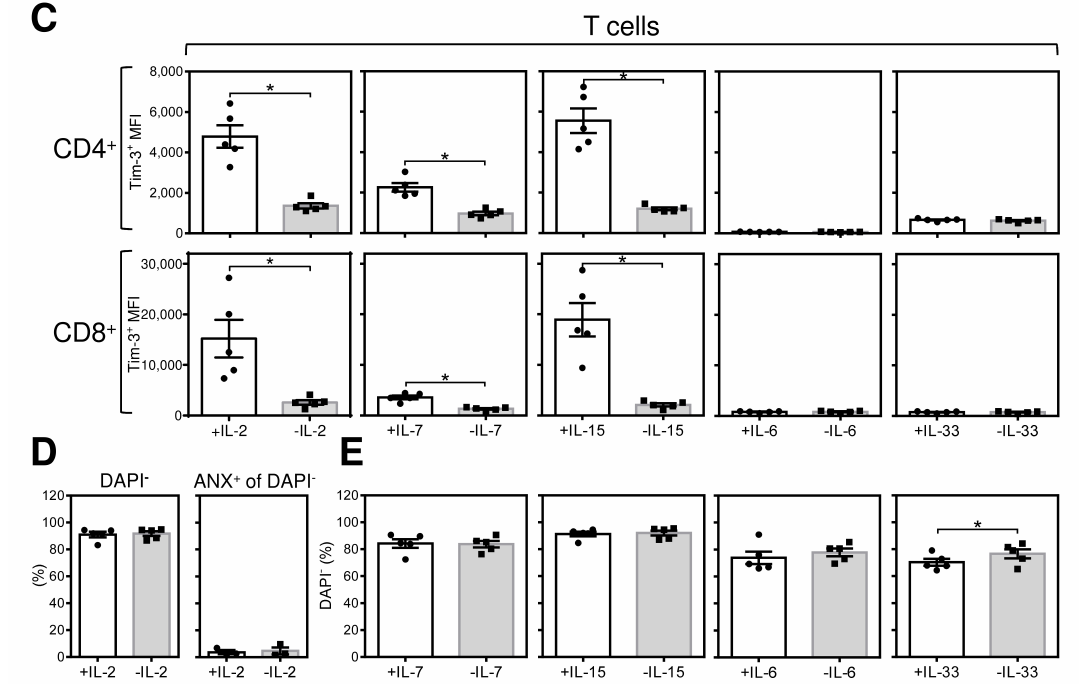
Figure 3. IL-2, IL-7, and IL-15 induce reversible surface expression of Tim-3 in antigen-expanded T cells. The 14-day-expanded lymphocytes were reconstituted and cultured for 18–24 h with IL-2 (133 IU / mL), IL-7 (13 IU / mL), IL-15 (133 IU / mL), IL-6 (666 IU / mL), or IL-33 (1333 IU / mL). The cells were washed and resuspended in fresh LM medium with or without cytokines. After 18–24 h, the cells were analyzed by flow cytometry for Tim-3 surface expression. ( A ) The gating strategy used to analyze flow cytometry data. ( B ) The proportions of the Tim-3 + population of CD4 + T cells and CD8 + T cells. ( C ) Intensities of Tim-3 staining (MFIs) of Tim-3 + CD4 + T cells and Tim-3 + CD8 + T cells. ( D ) The proportions of viable (DAPI − ) cells and the proportions of their annexin V + (ANX + ) populations. The gating strategy for annexin V staining is shown in Figure S2D. ( E ) The proportions of viable (DAPI − ) cells. In ( B – E ), bars represent the mean of values determined in each group, and the significance of di ff erences between the group of cells with ( + ) or without ( − ) the indicated cytokine is indicated (* p < 0.05, n = 3 donors for